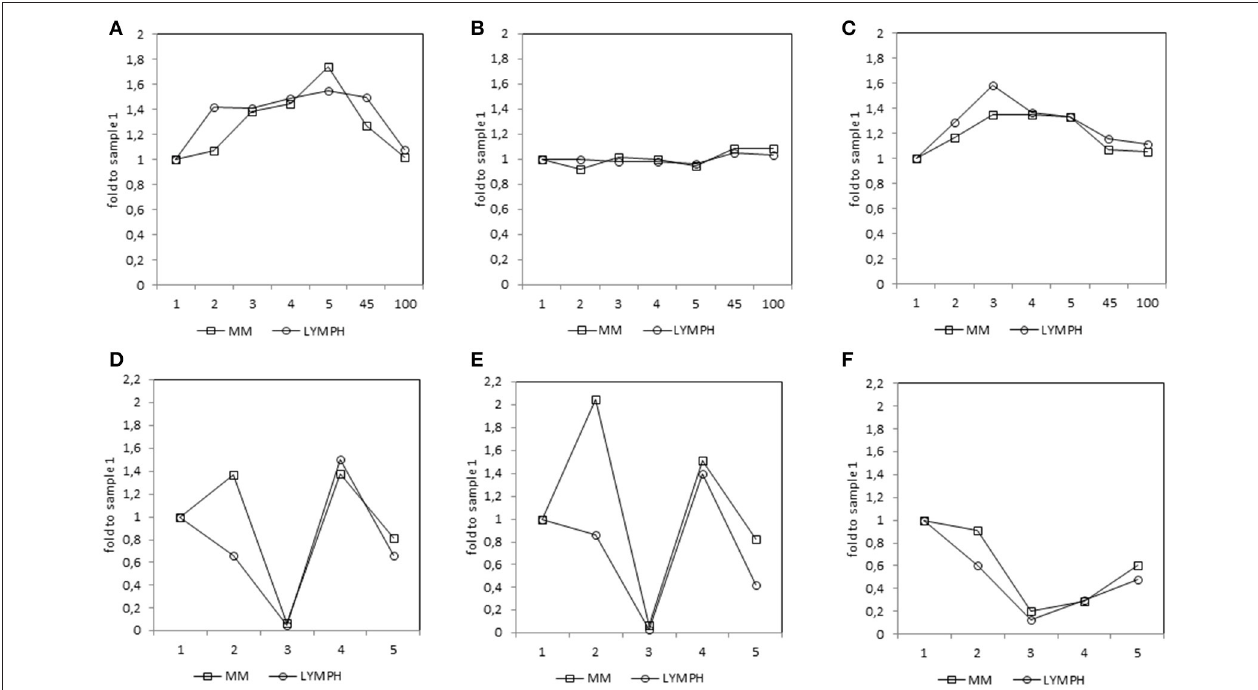
FIGURE 4 | Relative (median fold to sample 1) changes in concentrations of MBL (A) , CL-LK (B), and MASP-2 (C) and blood morphology: white blood cells (WBC) count (D) , absolute neutrophil count (ANC) (E) and platelet (PLT) count (F) in patients, during treatment. 1—blood taken directly before conditioning chemotherapy; 2—blood taken directly before autologous hematopoietic stem cell transplantation; 3—blood taken 1 week (mean 7.0 ± 0.8 days) after HSCT; 4—blood taken 2 weeks after HSCT (mean 13.6 ± 1.2 days); 5—blood taken 3 weeks after HSCT (mean 20.3 ± 2 days); 45—blood taken 45 days after HSCT (mean 45.3 ± 7.6